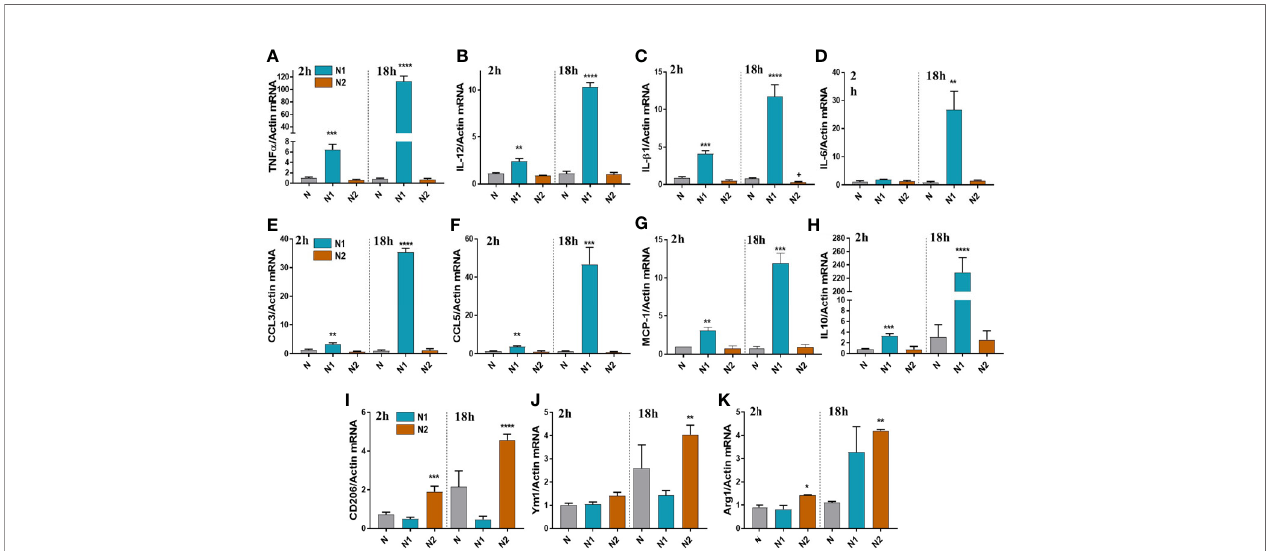
FIGURE 2 | Gene expression of in fl ammatory and anti-in fl ammatory markers in neutrophils polarized for 2 or 18h with LPS+IFN g (N1) or IL-4 (N2). (A – G) qPCR for in fl ammatory markers: TNF a , IL-12, IL-1 b , IL-6, CCL3, CCL5, MCP-1, in N1 and N2 compared to control neutrophils (N). (H – K) qPCR for anti-in fl ammatory markers: IL-10, CD206, Ym1 and Arg1, in N1, N2 and N. n = 5, *p < 0.05, **p < 0.01, ***p < 0.001, ****p < 0.0001 (N1 or N2 vs .